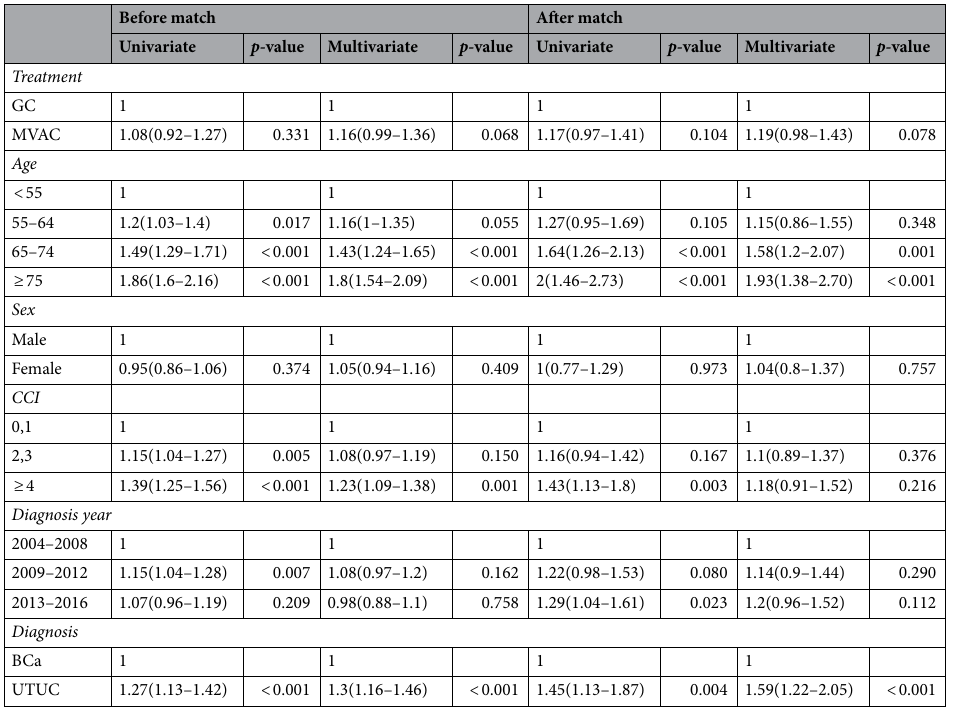
Comorbidity Index; BCa, Bladder cancer; UTUC, Upper tract urothelial